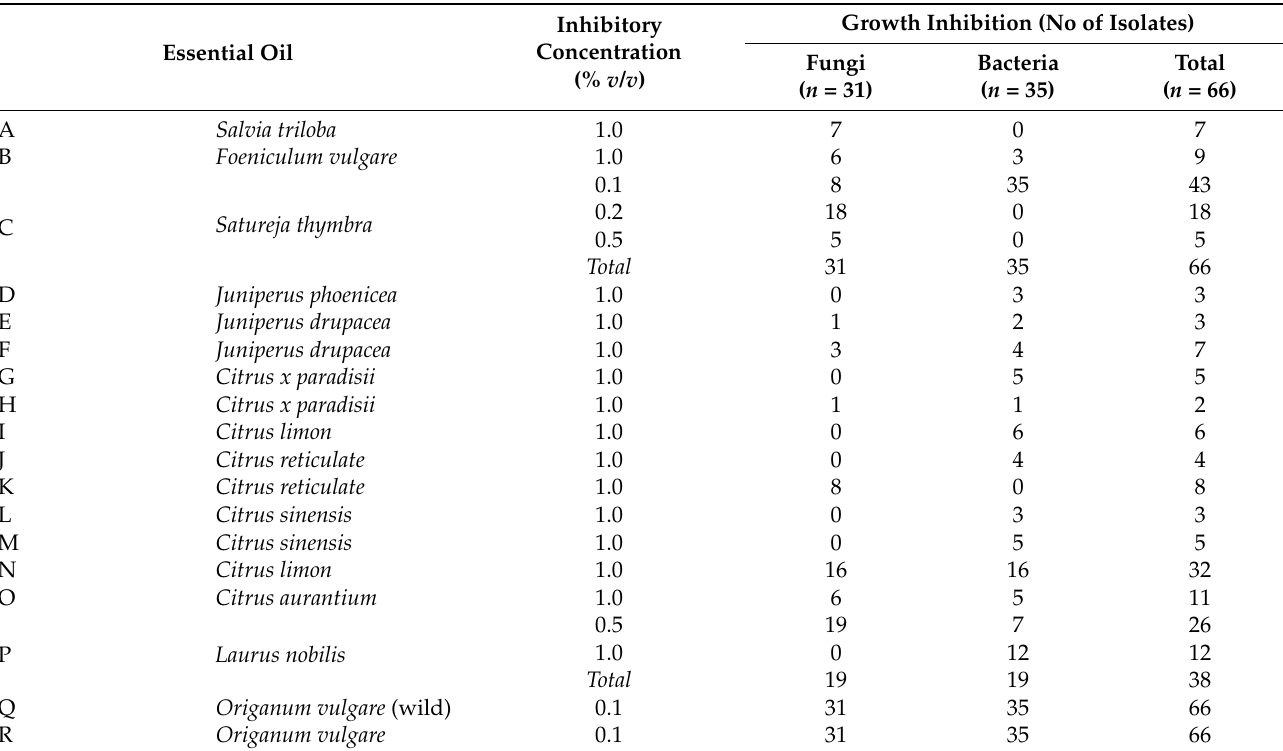
Table 4. Total number of bacterial and fungal isolates inhibited by the 18 EOs in concentrations up to 1% ( v / v